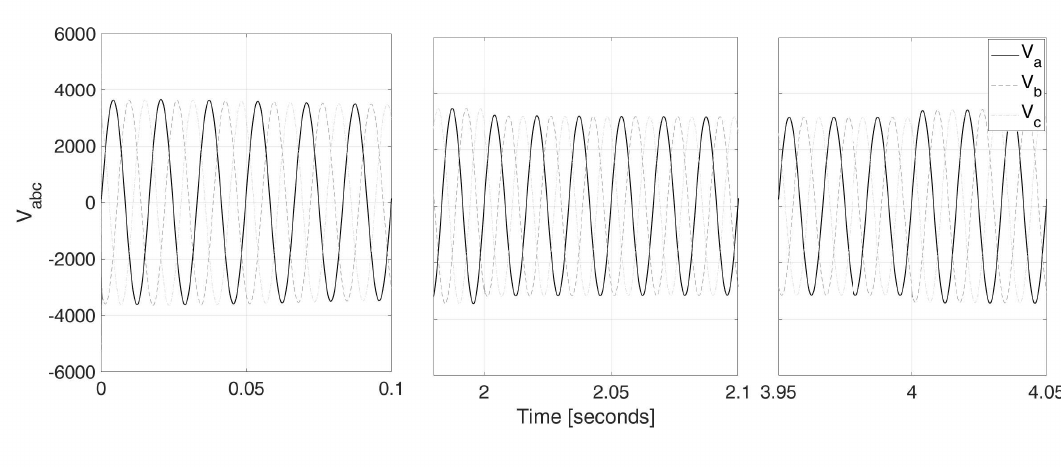
Figure 13. Simulation of voltages v abc during Test 2, with PI